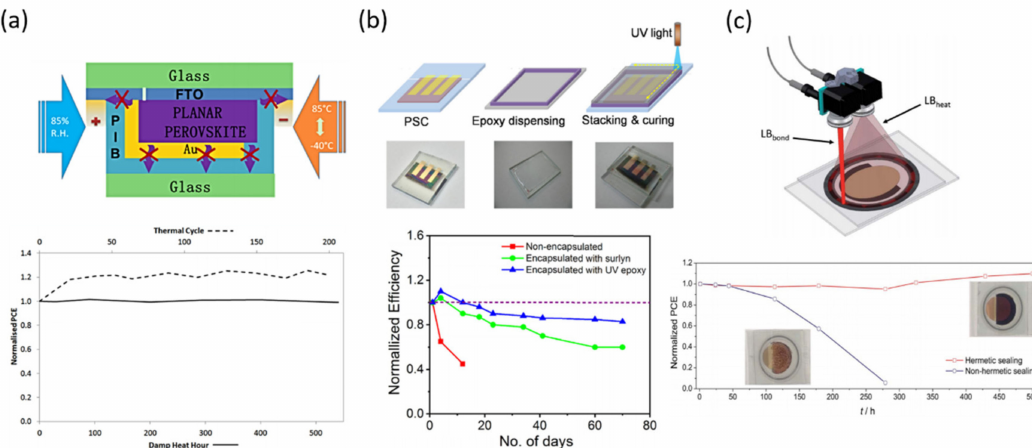
Figure 3. Glass-to-glass encapsulation methods. ( a ) Schematic illustration of polyisobutylene (PIB) blanket used as cover encapsulant and edge sealant for perovskite solar cell and its corresponding normalized PCE during thermal cycle test. Reproduced with permission of Ref. [45]. ( b ) Top-row of glass-to-glass encapsulation of PSC with UV-curable epoxy edge sealant and its corresponding normalized PCE during stability test. Reproduced with permission of Ref. [75]. ( c ) Scheme of laser-assisted glass frit sealing process with dual laser beam configuration and its corresponding normalized PCE during stability test. Reproduced with permission of Ref.